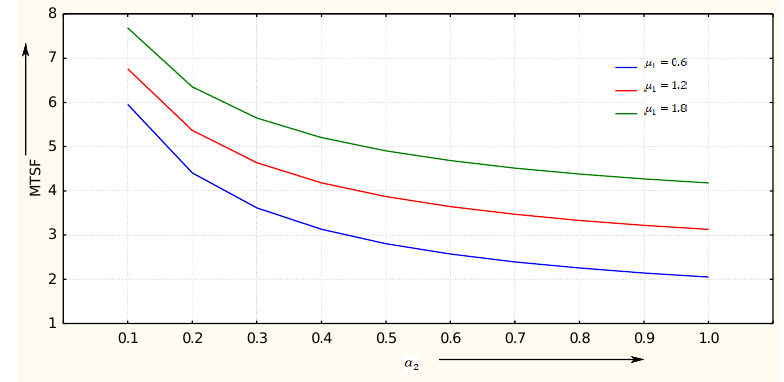
Figure 4. Behaviour of MTSF w.r.t 𝛼